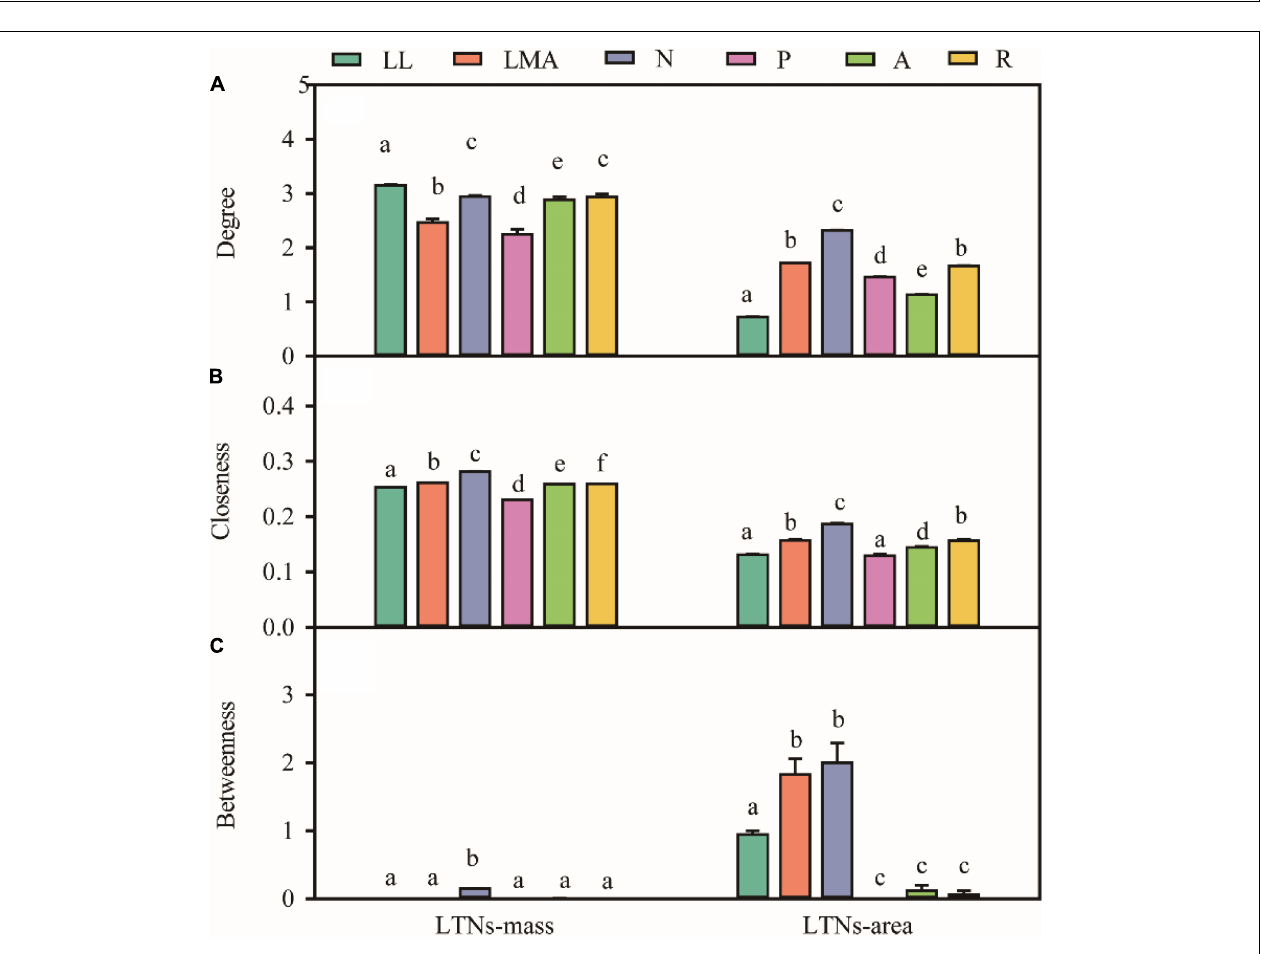
FIGURE 3 | Variation in degree (A) , closeness (B) , betweenness (C) for different leaf trait networks (LTNs) on mass-based and area-based leaf traits. Different letters indicated the significant difference ( P < 0.05). Error bars were represented standard error (SE).